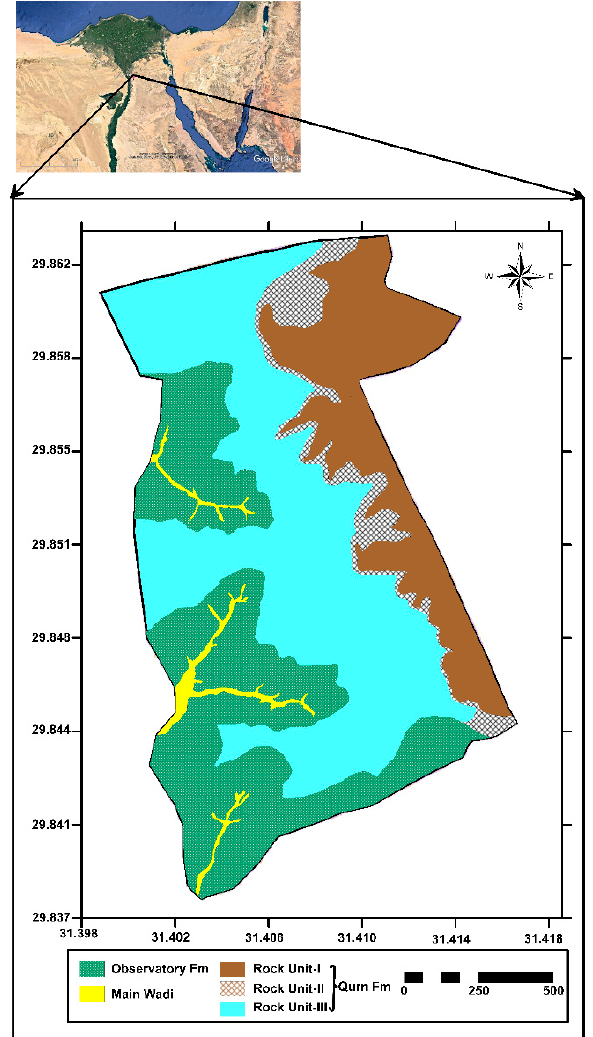
Figure 2. A map showing the geological units of the investigated site with respect to Egypt. Topographically, the geological setting of the investigated site directly impacted the topographical regime, as they are inter-related, where the general topographical regime (high plateaus and terraces) is influenced completely by weathering and erosion processes.